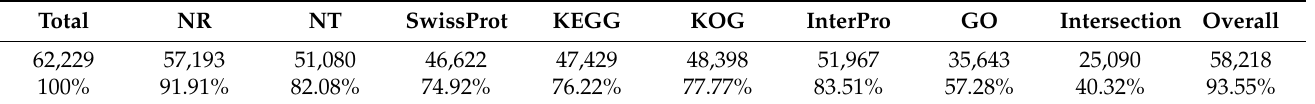
Table 3. Summary of functional annotation results for all isoforms in the seven